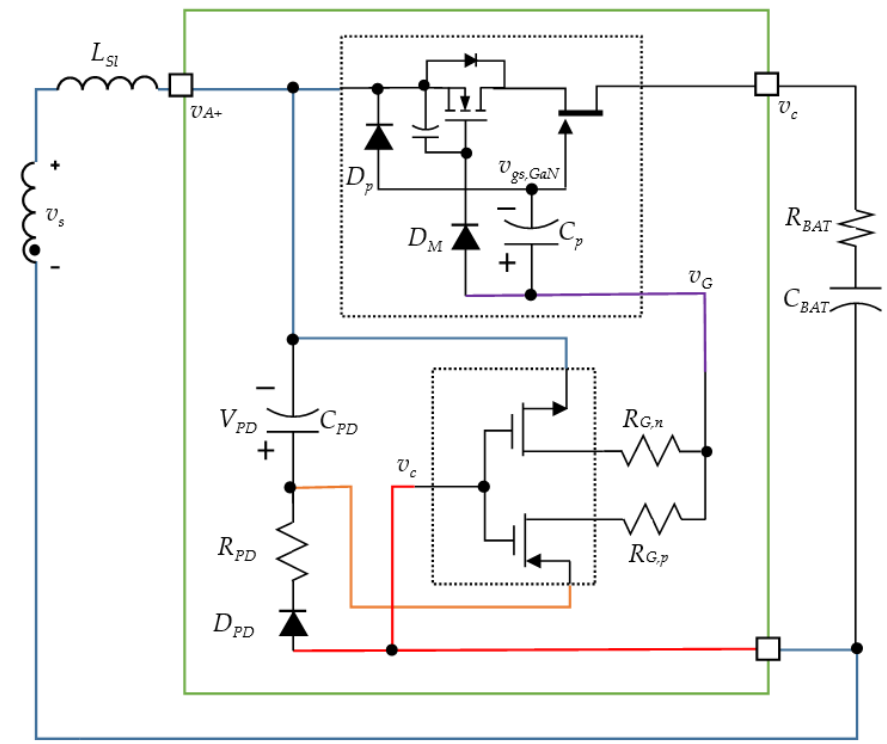
Figure 6. The D-Mode GaN HEMT Synchronous Rectifier.